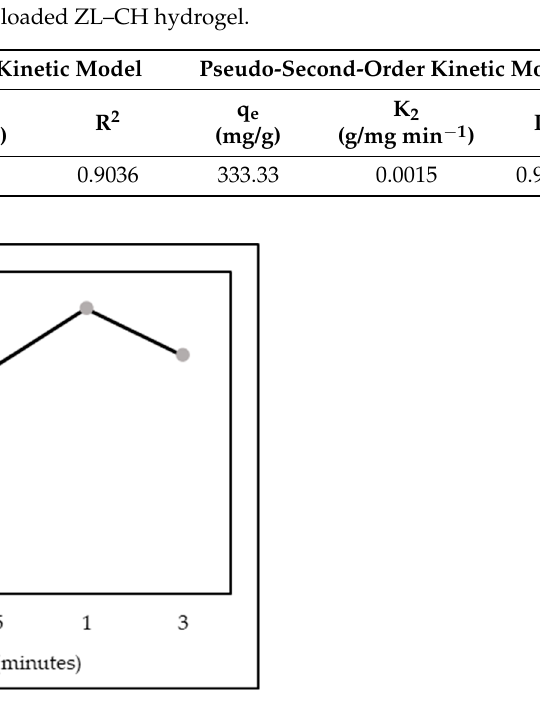
Figure 14. Effect of contact time of swelling studies (ZL–CH hydrogel = 30 mg, initial AR88 concen- tration = 100 mg/L, pH 2.0).